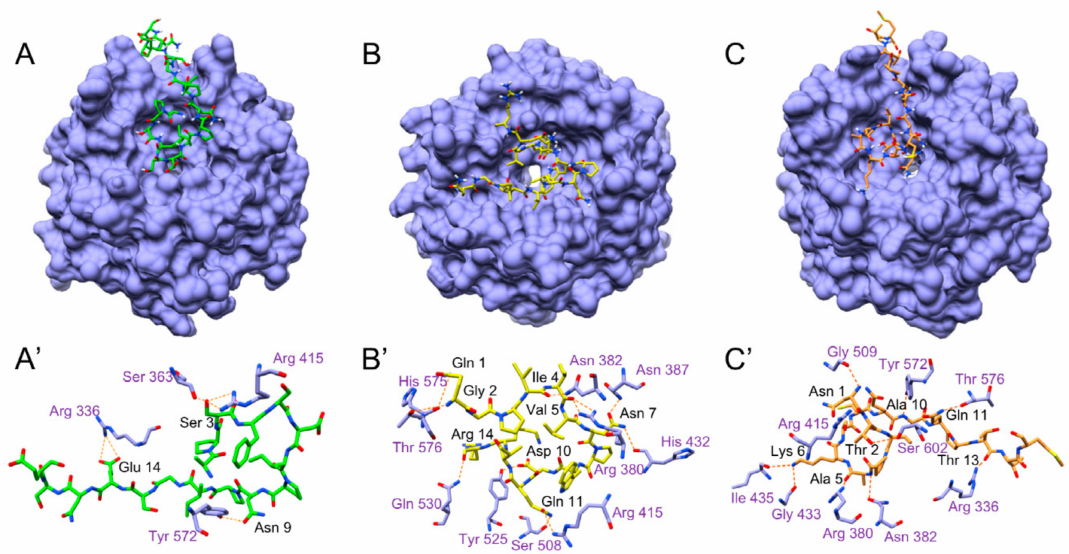
Figure 7. Molecular docking analysis of the interaction between peptides and Keap1 Kelch domain. ( A–C ) Binding geometry of A-17-E , Q-14-R and N-15-M in the pocket of Keap1. ( A’–C’ ) Magnification of the interaction of Keap1 Kelch domain with A-17-E ( A’ ), Q-14-R ( B’ ) and N-15-M ( C’ ). Amino acids involved in the hydrogen bond formation were connected with orange dashed lines and highlighted